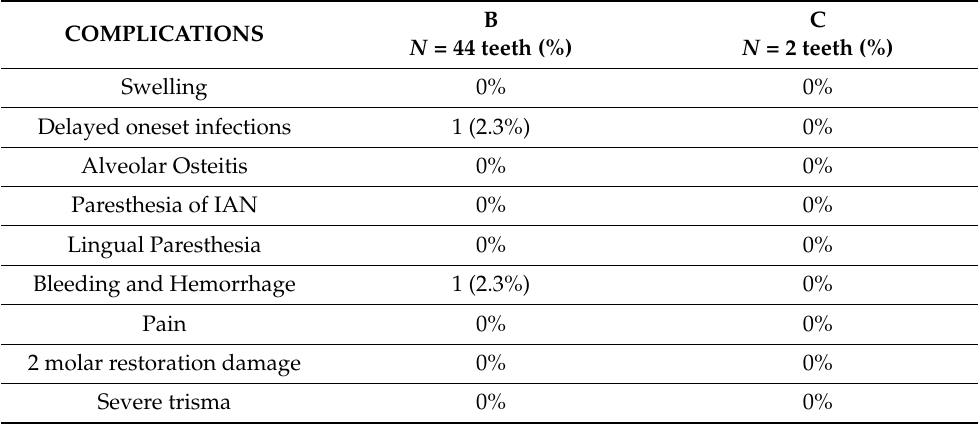
Table 2. Complications according to the position of the impacted mandibular third molars (Winter’s classification). B: mesio-angular position; C: vertical position